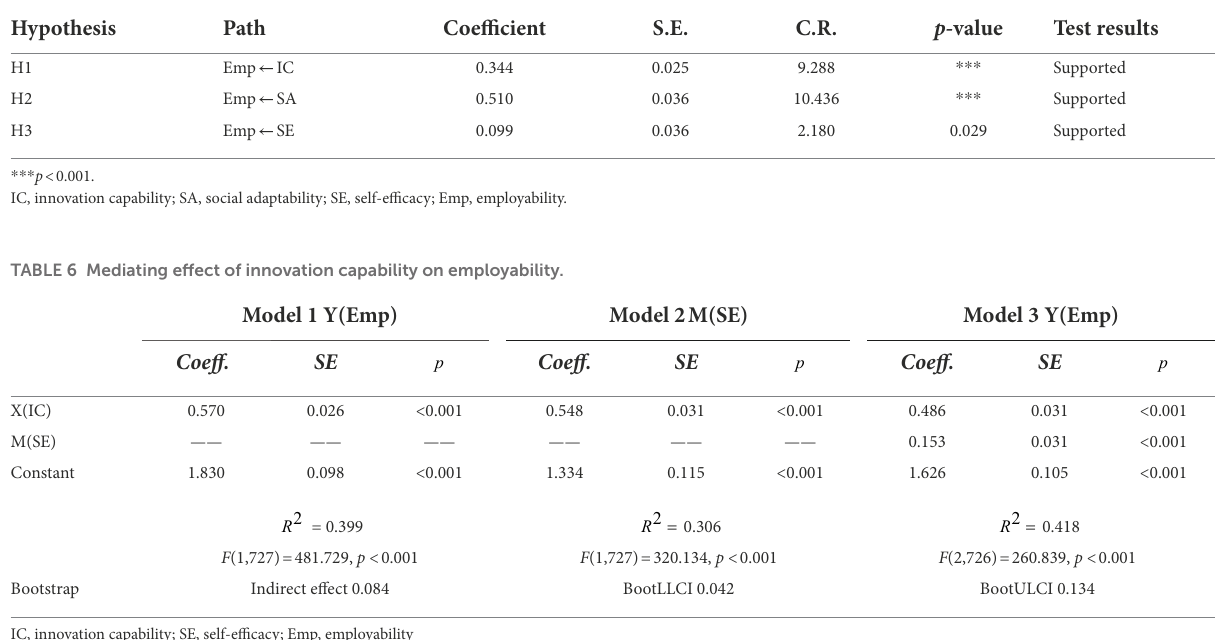
TABLE 5 Path coefficient estimates of the proposed SEM.